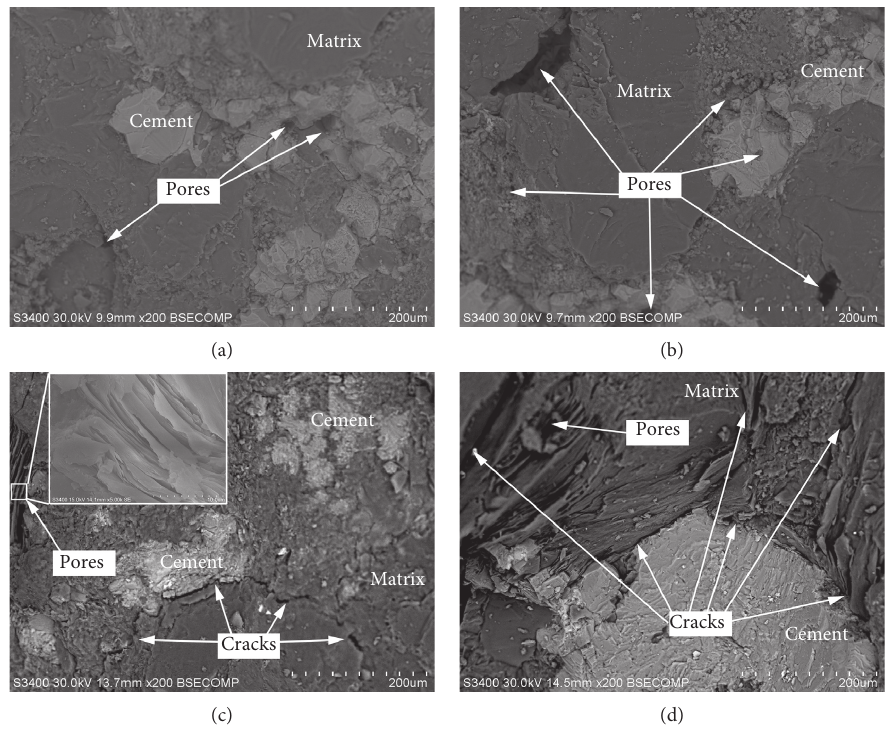
Figure 14: BSE image of specimens in different A-D-W cycle stages (at pH � 4): (a) Stage I, (b) Stage II, (c) Stage III, and (d) Stage IV.